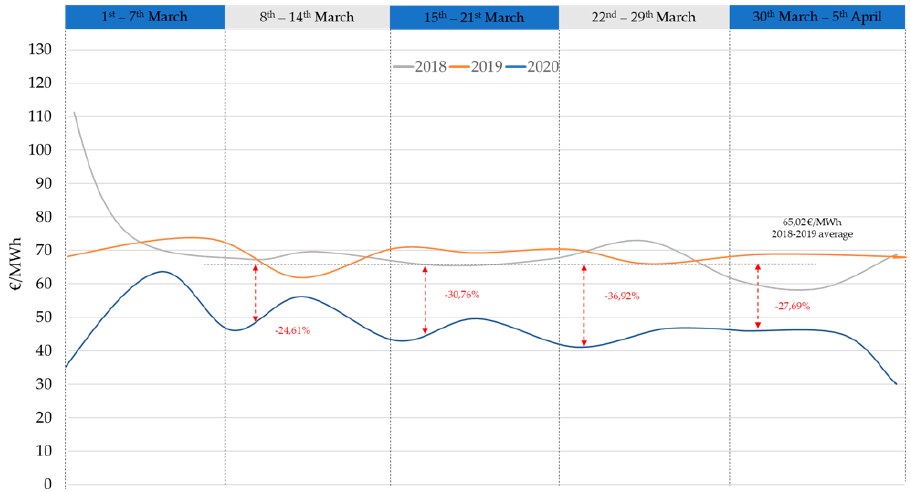
Figure 17. Average PUN comparison between 2018, 2019 and 2020.